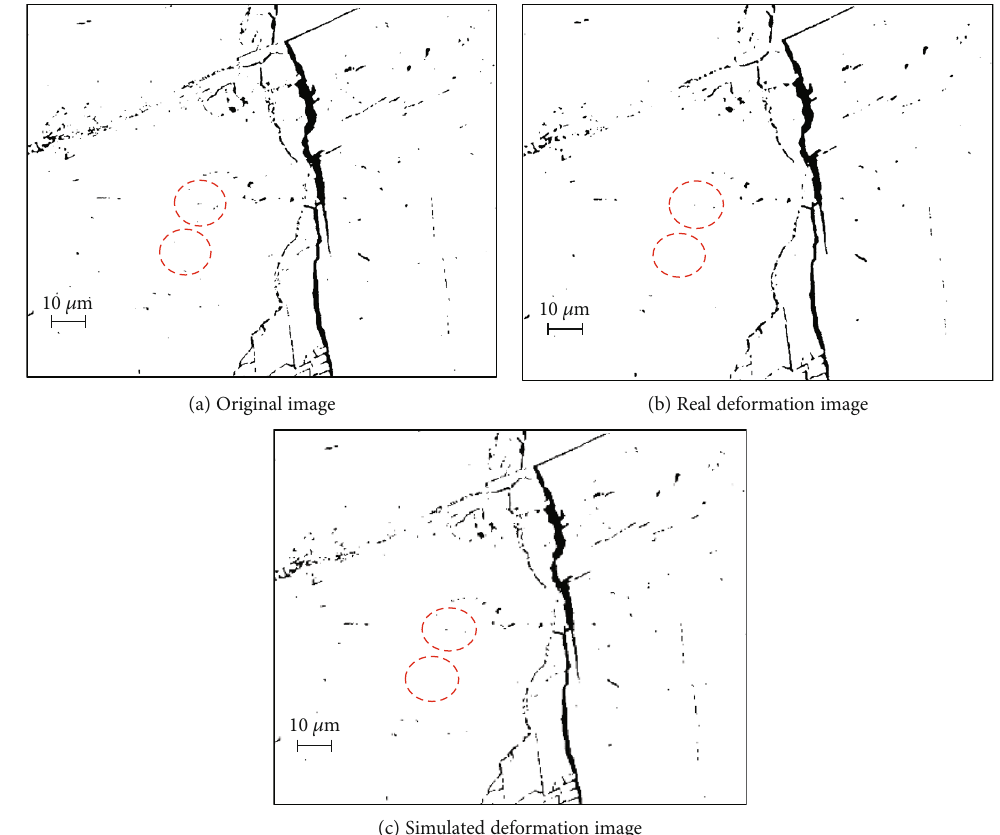
Figure 7: Binary images of real deformation and simulated